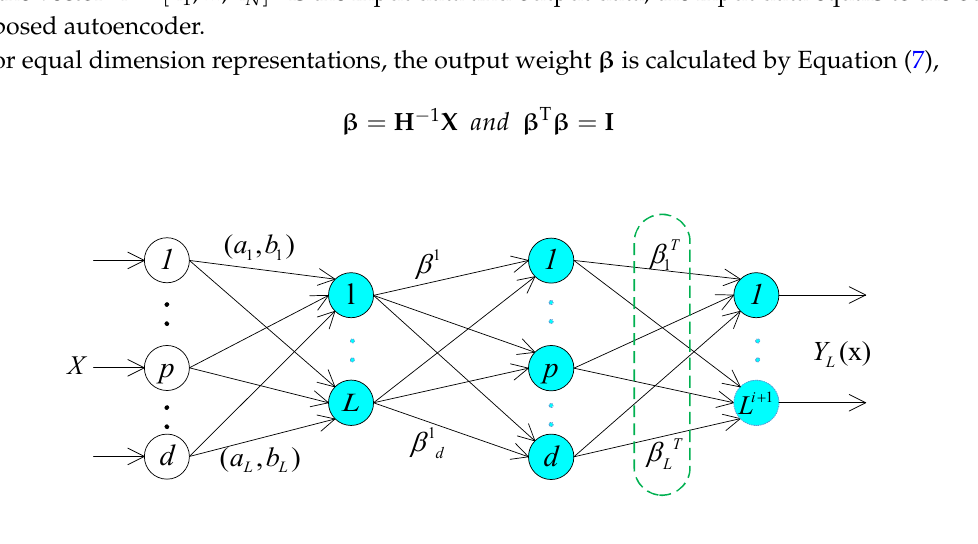
Figure 3. ELM orthogonal random feature